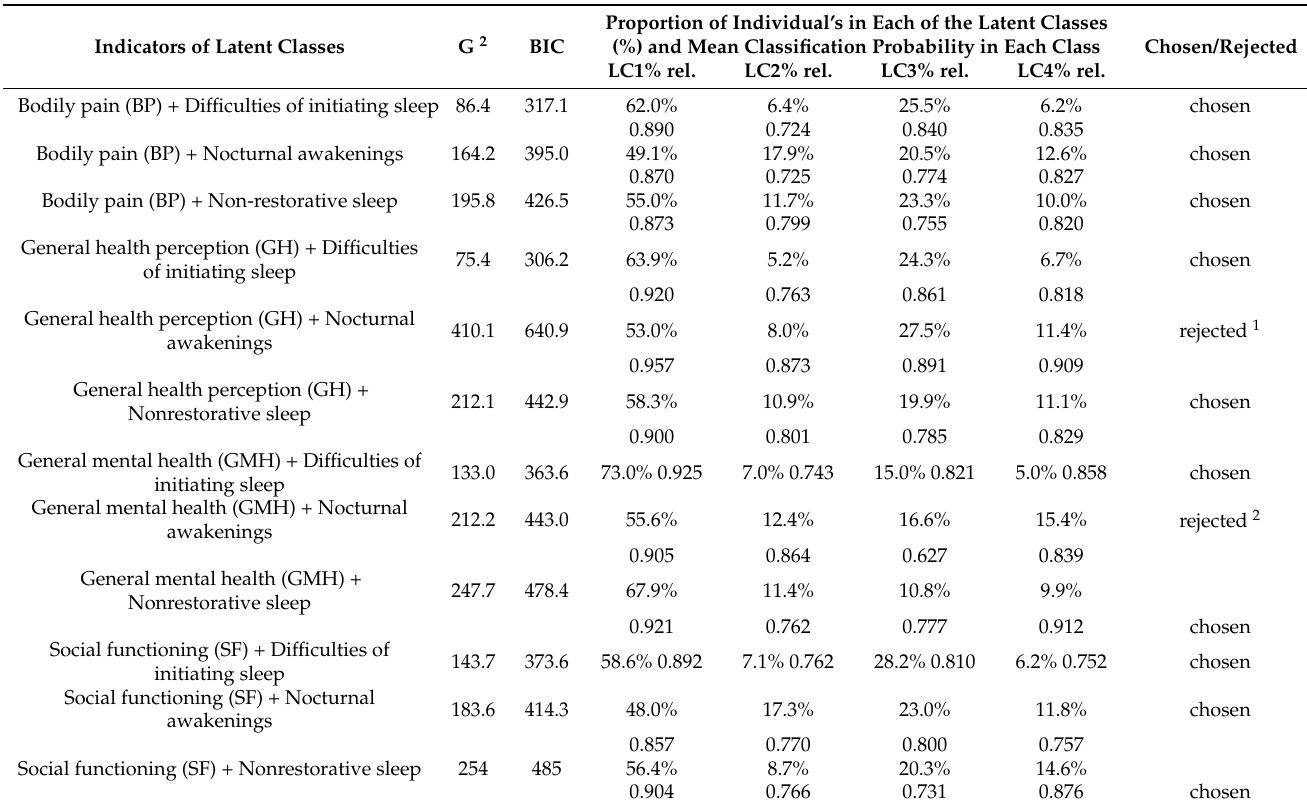
Table 3. RMLCA models with four class solutions. Whether the model was chosen or rejected is indicated. Membership prevalence (%) and reliability (rel.) of posterior class membership probability (between 0 and 1.0) are also shown for each latent class. Proportion of Individual’s in Each of the Latent Classes (%) and Mean Classification Probability in Each Class Chosen/Rejected G 2 BIC LC1% rel. LC2% rel. LC3% rel. LC4%